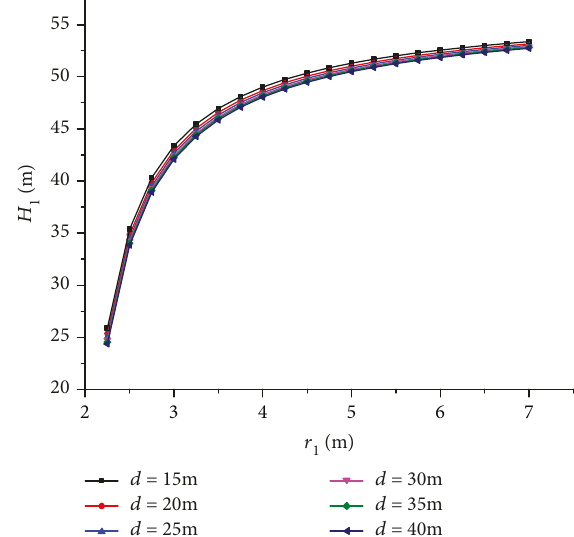
Figure 12: Relationship between the pressure head and radius of the grouting